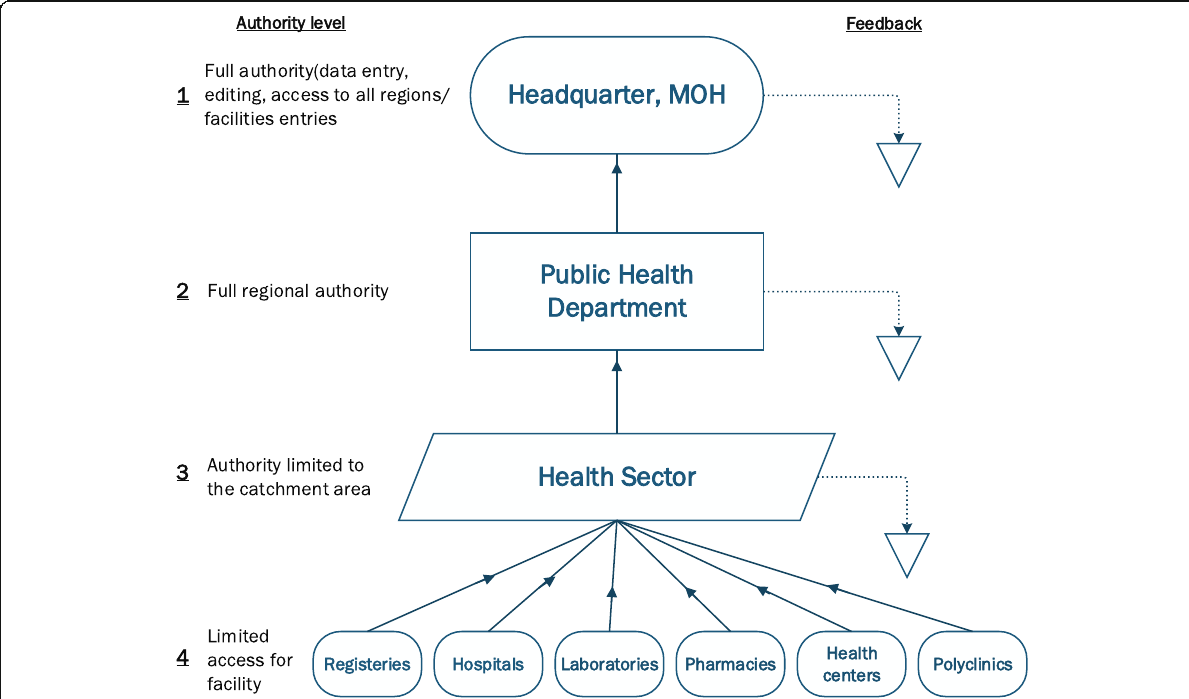
Fig. 1 Flowchart for information through the Health Electronic Surveillance Network (HESN) with regards to the authority level and the feedback